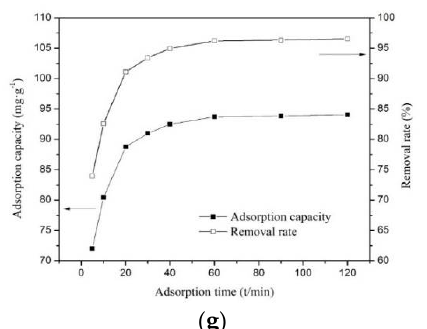
Figure 4. Dispersion of composite MAG–Fe 3 O 4 in deionized water: ( a ) before the action of the magnetic field, and ( b ) after the action of the magnetic field; ( c ) Adsorption capacity of MAG, Fe 3 O 4 , and MAG–Fe 3 O 4 (At 25 °C, pH = 7, 100 mg/L MB solution, 1.0 g/L MAG–Fe 3 O 4 ); and effects of ( d ) MAG–Fe 3 O 4 dosage on adsorption capacity and removal rate, ( e ) pH on adsorption capacity and removal rate, ( f ) initial concentration of MB on adsorption capacity and removal rate, ( g ) adsorption time on adsorption capacity and removal rate.